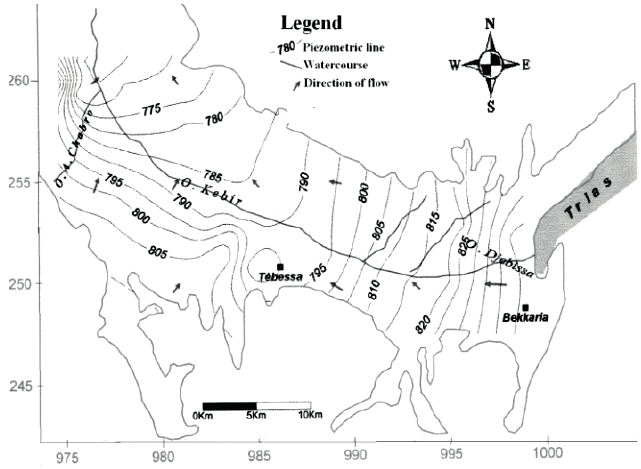
Fig. 3 Piezometric map of Tebessa plain (Ghrieb